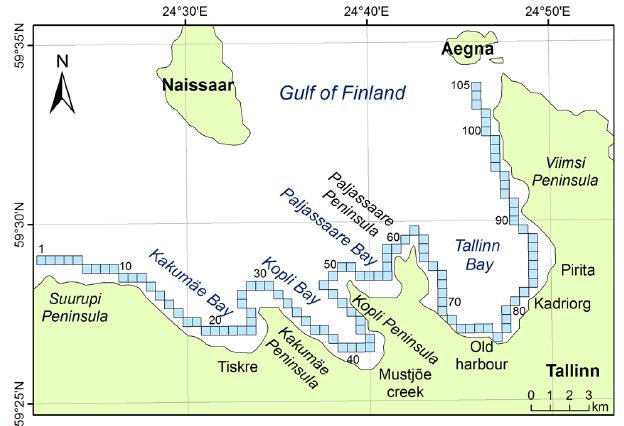
Fig. 2. Selected nearshore grid cells of the wave model. The cells are numbered sequentially starting from the westernmost